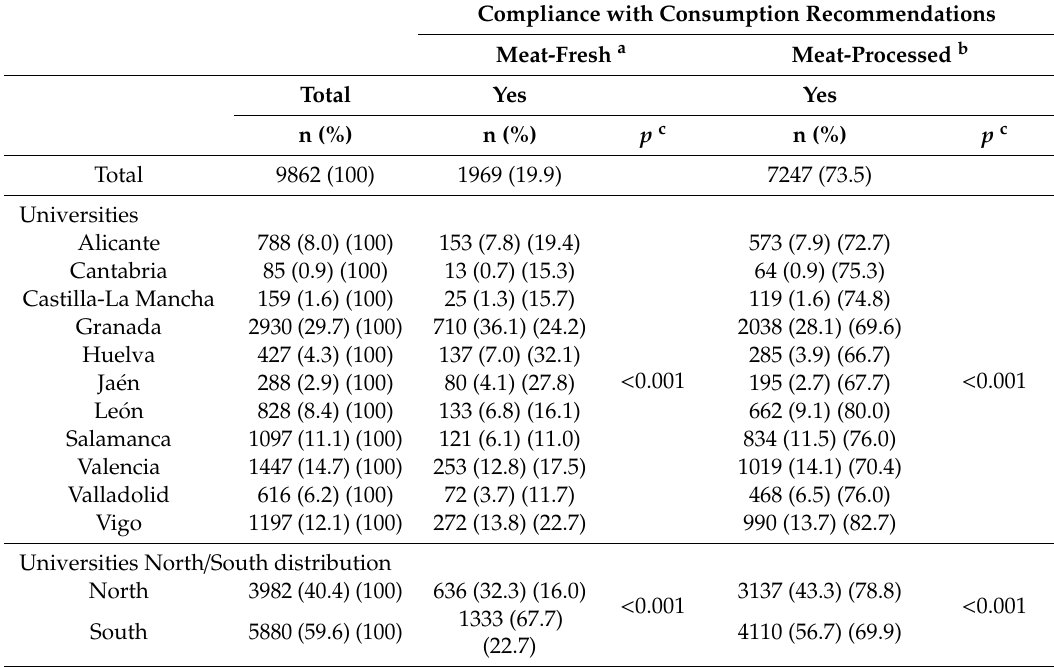
Table 2. Compliance with the recommendations on the frequency of consumption of fresh meats and processed meats by universities and according to geographical